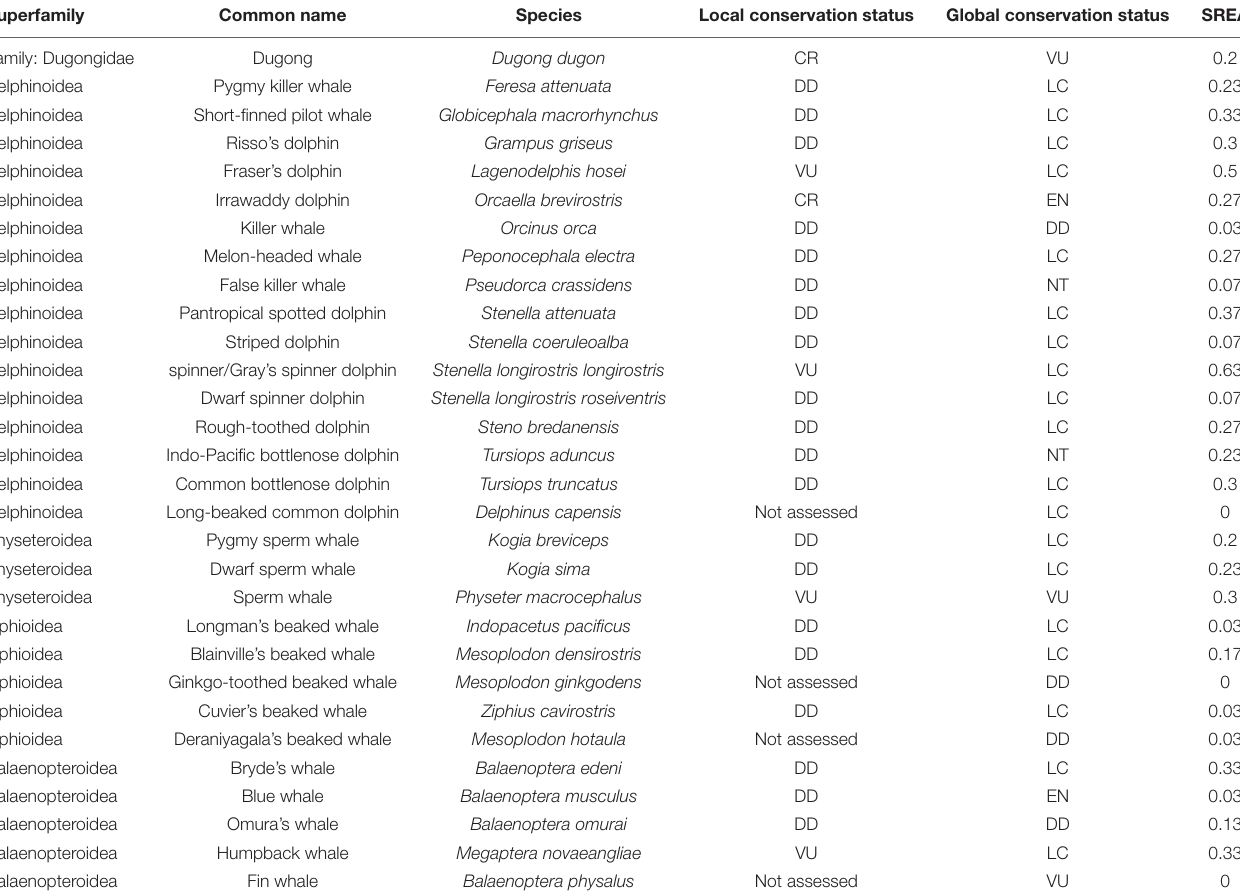
TABLE 2 | Research allocation of 30 marine mammal species provisionally listed to occur in Philippine waters.